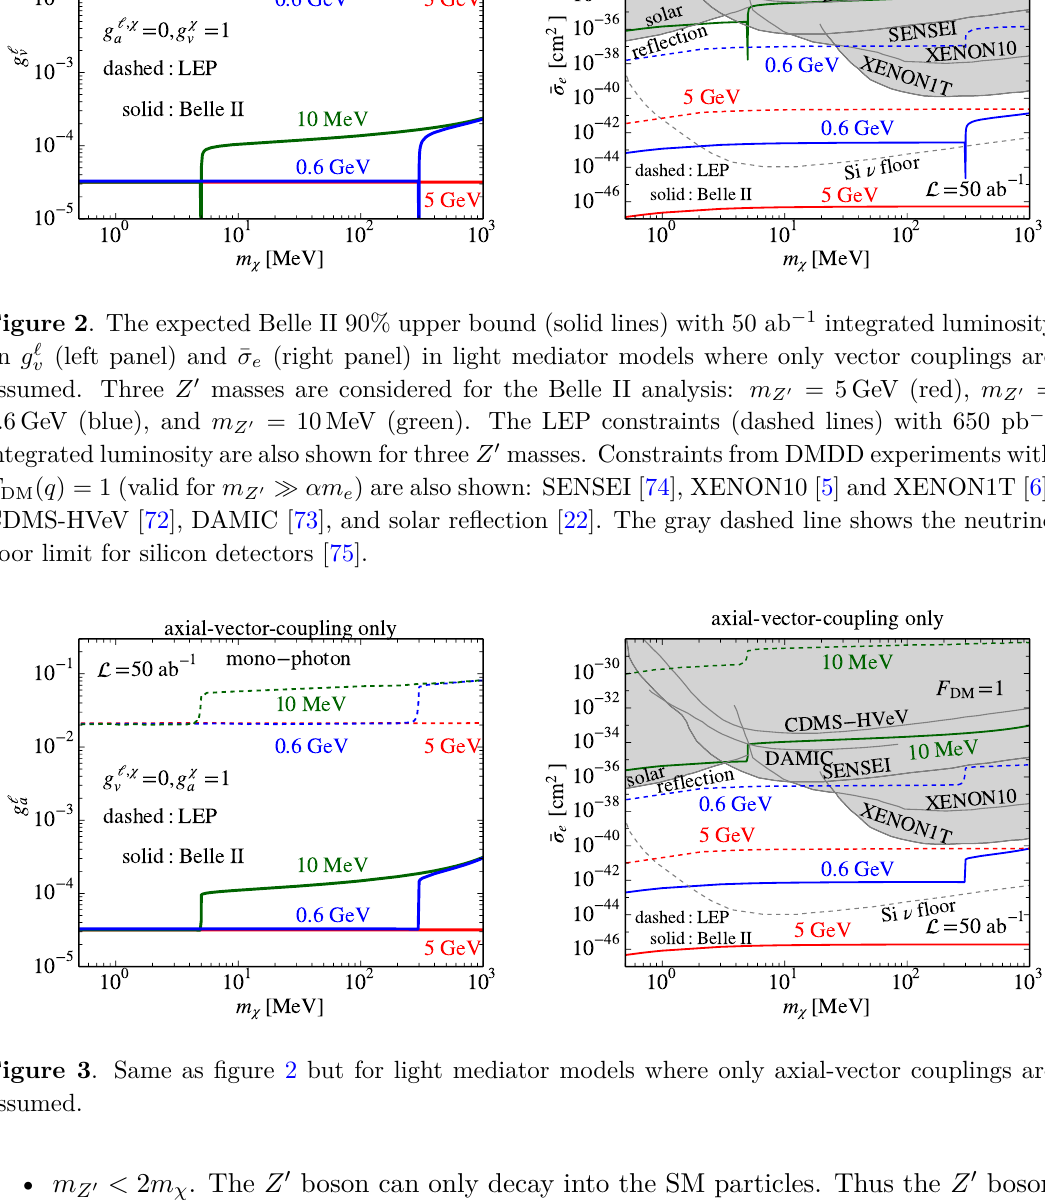
Figure 3 . Same as figure 2 but for light mediator models where only axial-vector couplings are